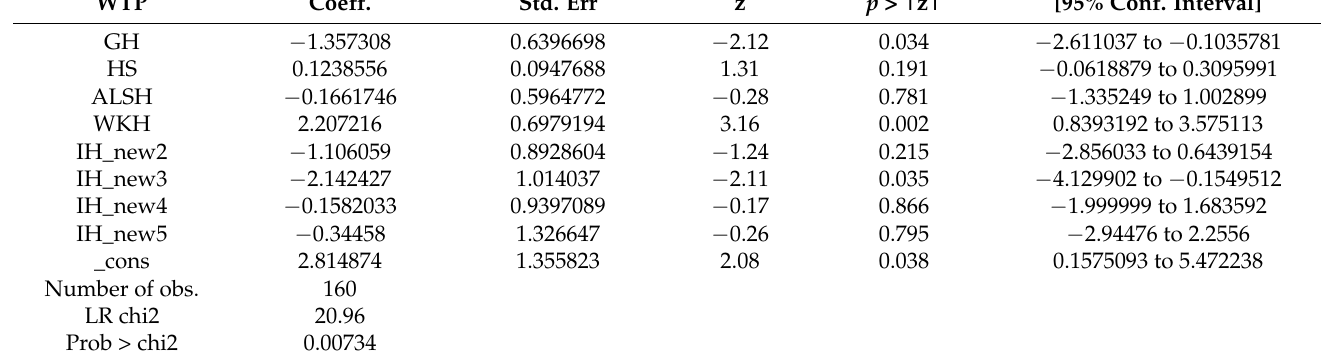
Table 6. Results of ordered logistic regression on determinants of the WTP nested model C.